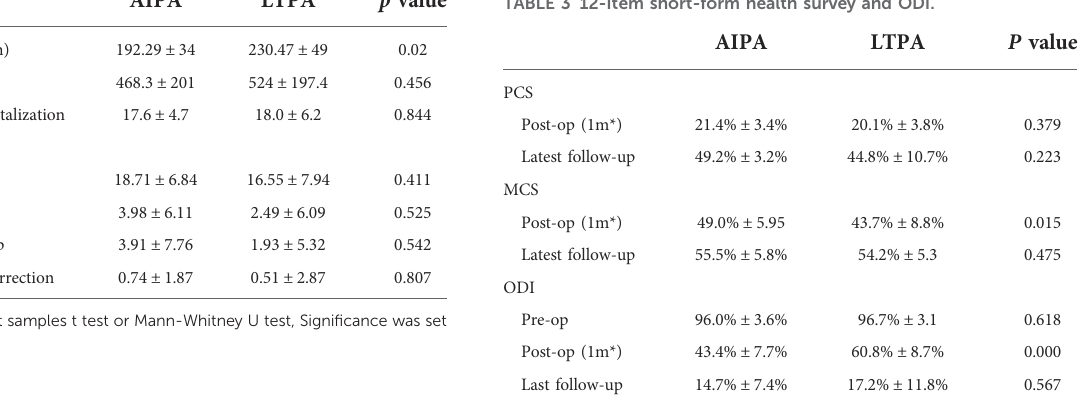
TABLE 3 12-Item short-form health survey and ODI.